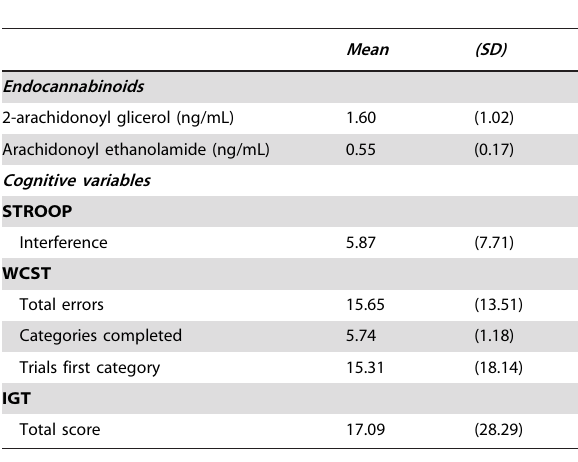
Table 2. Descriptives (mean and standard deviation) for endocannabinoids and cognitive